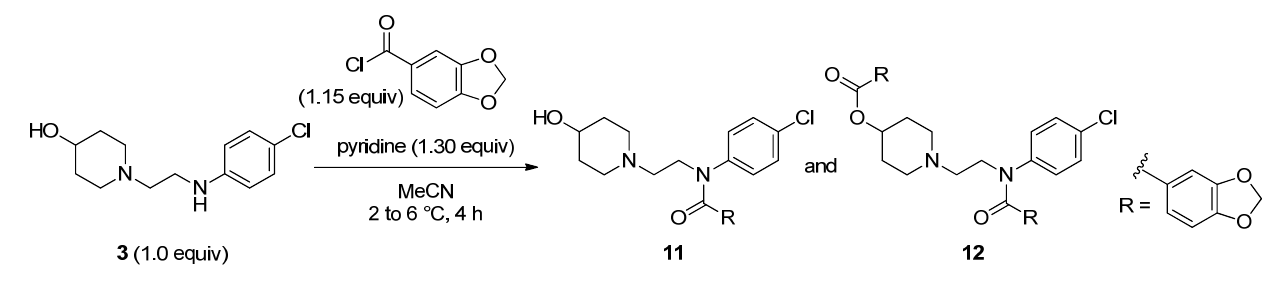
Table 2. Construction of the piperonyl amide moiety a